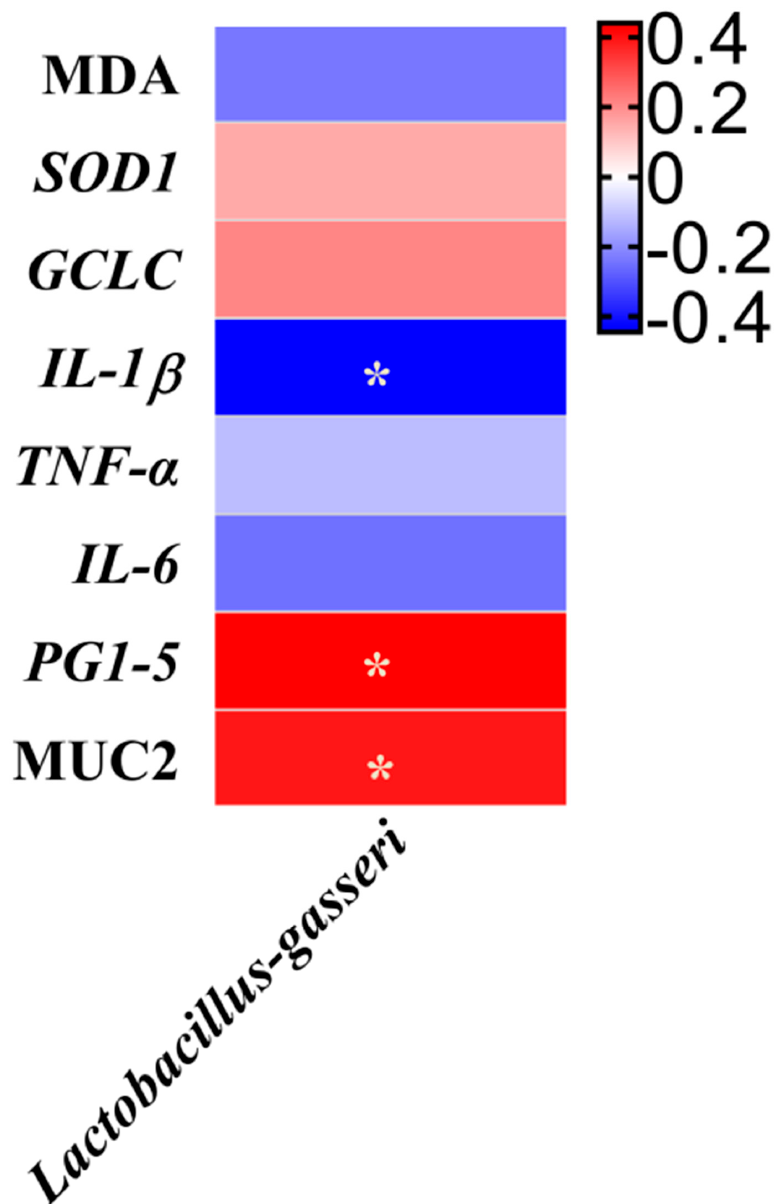
Figure 4. Heatmap of Pearson correlation coefficients between the intestinal inflammation and oxidative damage and the relative abundance of Lactobacillus gasseri affected by RES and DON. * Significant correlation: * p ≤ 0.05. Red shading with p ≤ 0.05 represents a significant positive correlation; blue shading with p ≤ 0.05 represents a significant negative correlation; white represents no correlation. GCLC , glutamate–cysteine ligase catalytic subunit; IL-1 β , interleukin 1 beta; IL-6 , interleukin 6; MDA, malondialdehyde; Muc2 , mucin 2; PG1-5, protegrin 1-5; TNF- α , tumor necrosis factor-alpha.